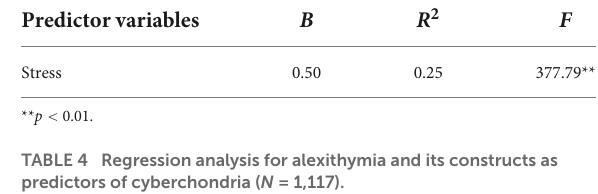
TABLE 3 Regression analysis for predicting cyberchondria from stress ( N = 1,117).